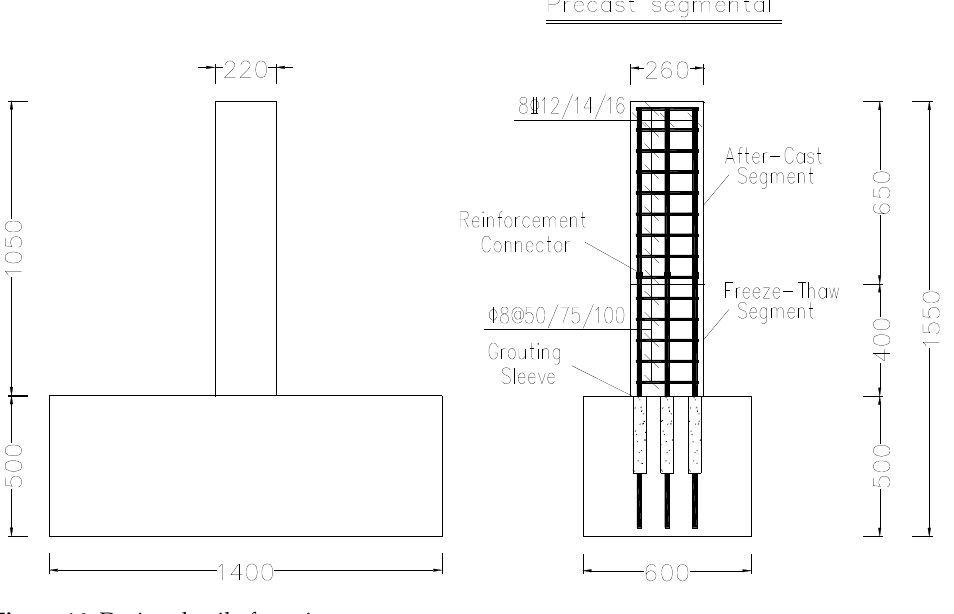
Figure 16. Design detail of specimens.